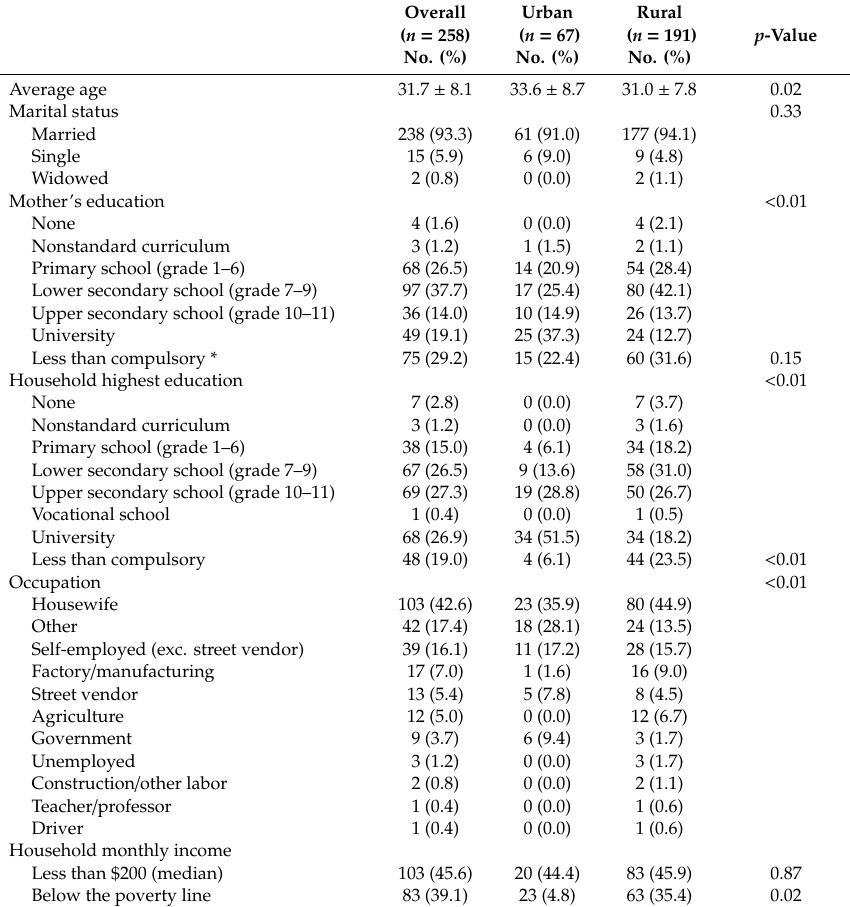
Table 1. Participants’